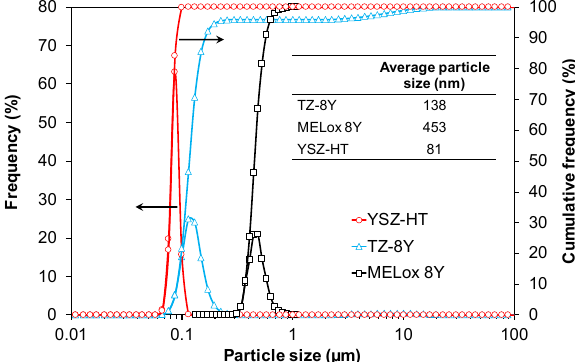
Fig. 2 Particle size distribution of the YSZ